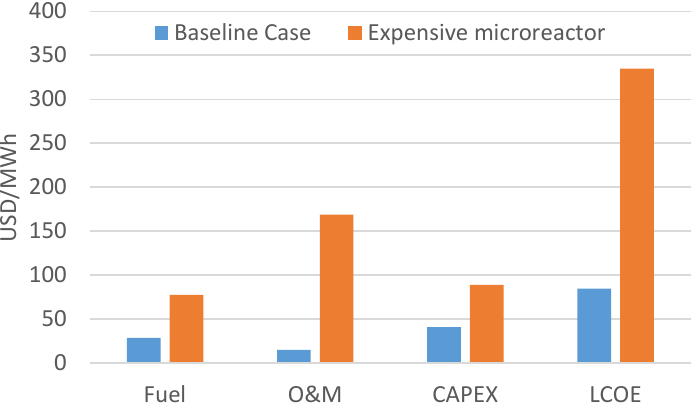
Figure 16. Levelized costs of fuel, O&M and capital costs (CAPEX) for the baseline case of Table 3, and a notional expensive micro-reactor design.